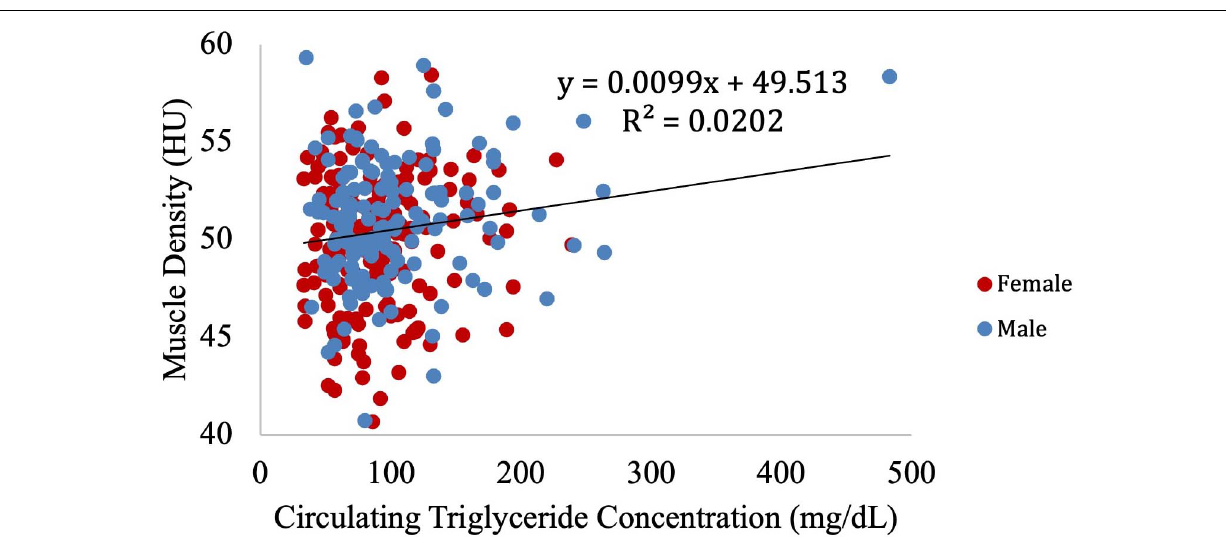
( Table 3 : Model 2), and general obesity markers ( Table 3 : Model 3). The association was linear across the muscle attenuation range of 40.7–59.3 normalized Hounsfield